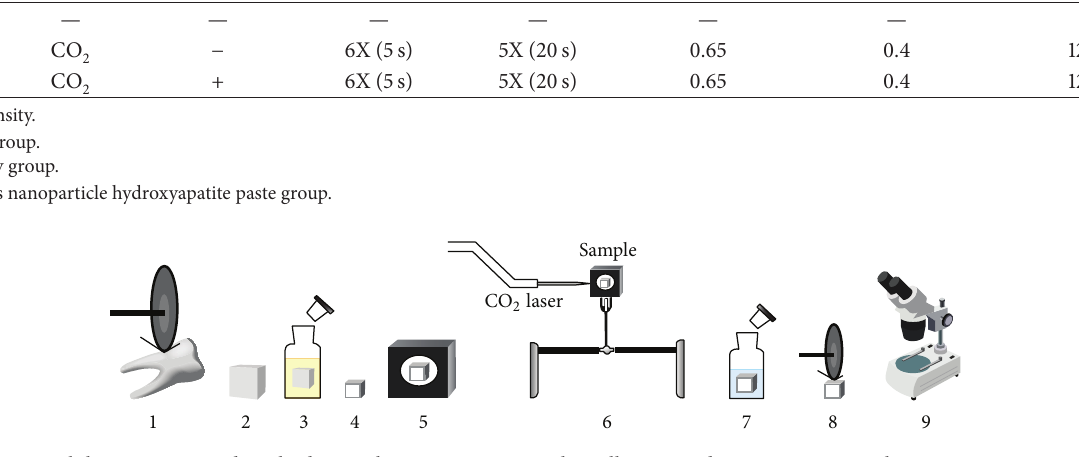
Figure 1: Permeability test setup and method. 1: tooth sectioning. 2: samples collection and cementum removal. 3: immersion in 1% citric acid for 5 min. 4: marking of the lasing area and nail varnish coating. 5: mounting in acrylic resin mold. 6: lasing, 7: immersion in 2% methylene blue for 1hr. 8: longitudinal sectioning. 9: stereomicroscopic examination.